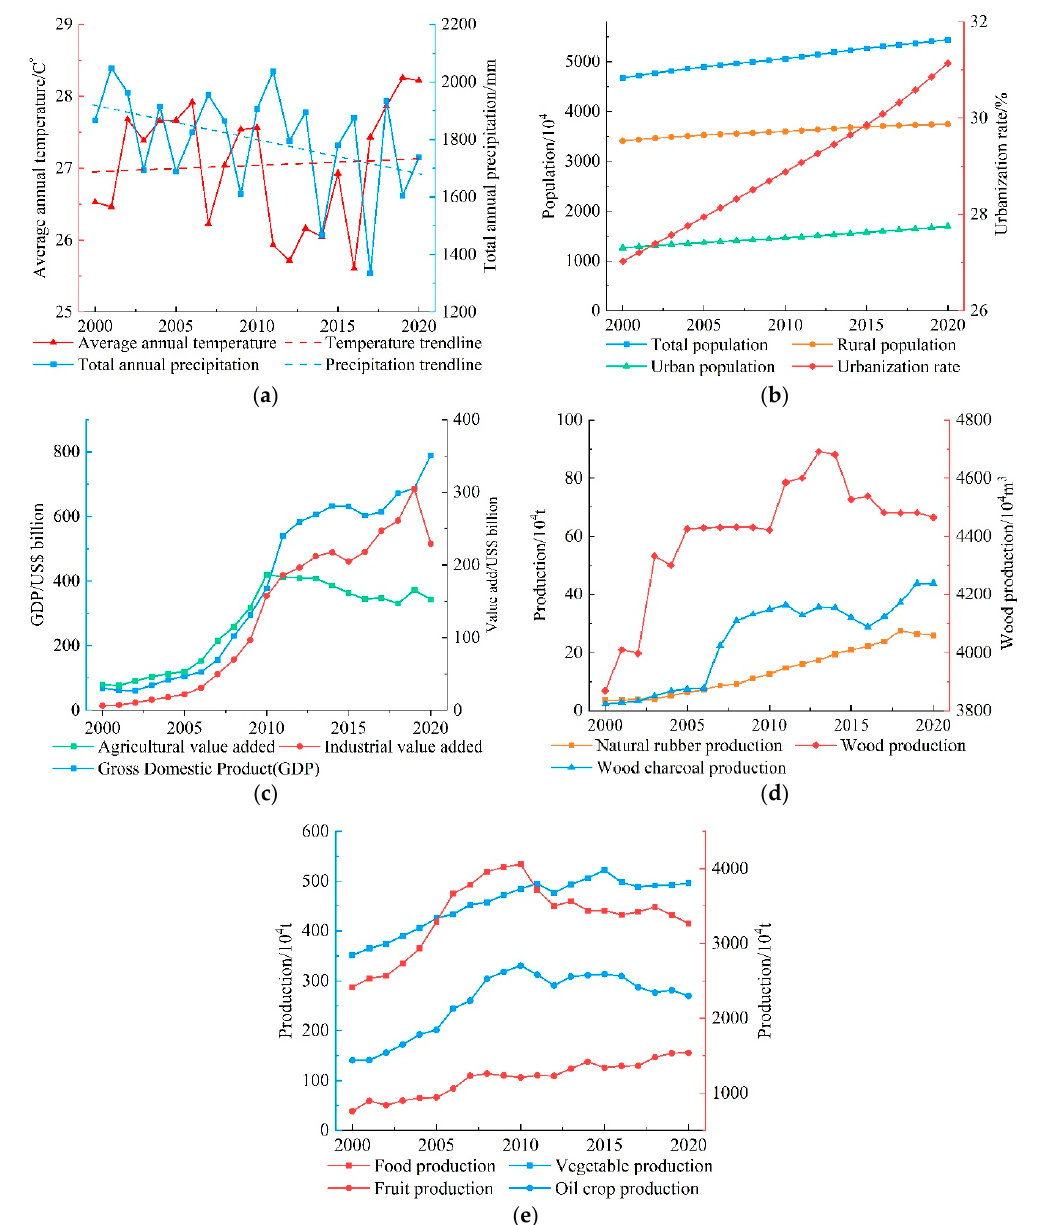
Figure 6. Development status in Myanmar from 2000 to 2020. ( a ) Climate factors; ( b ) demographic factors; ( c ) economic factors; ( d ) forestry factors; and ( e ) agricultural factors.